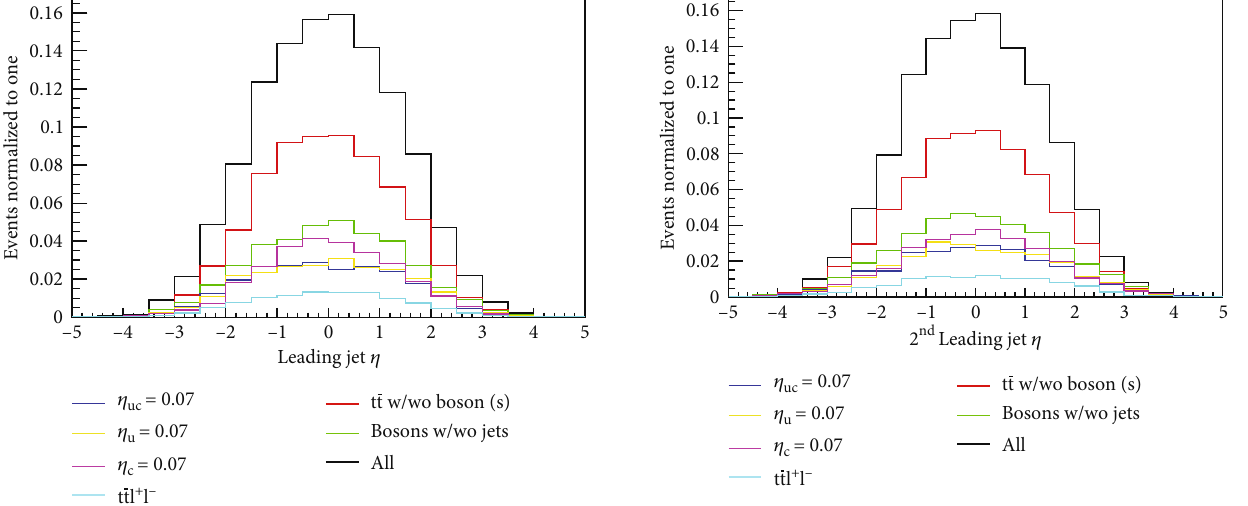
Figure 16: Second-leading jet η distribution at detector is central.